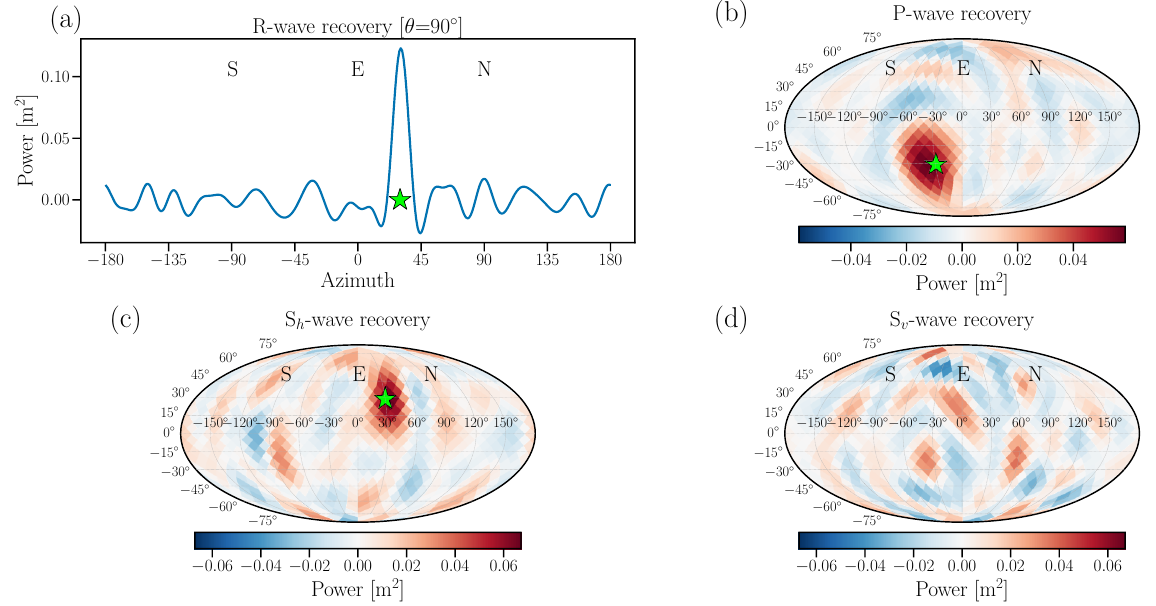
Figure 5. ( a – d ) R-, P-, S h -, S v -wave recoveries. R, P, and S h waves are simultaneously simulated with different propagation directions and are successfully recovered (no S v wave was simulated). The total recovered power is biased: the simulated power was uniform for all three signals, while the total power in the R-wave map was 0.85 m 2 ; for the P-wave map, it is 1.22 m 2 , and for the S h -wave map, it is 2.48 m 2 . Adding the power across all four maps yields a total amplitude of 4.01 m 2 , which is larger than what one would expect if all injections were uncorrelated. We assumed λ R = 2500 m, λ P = 5700 m, and λ S = 4000